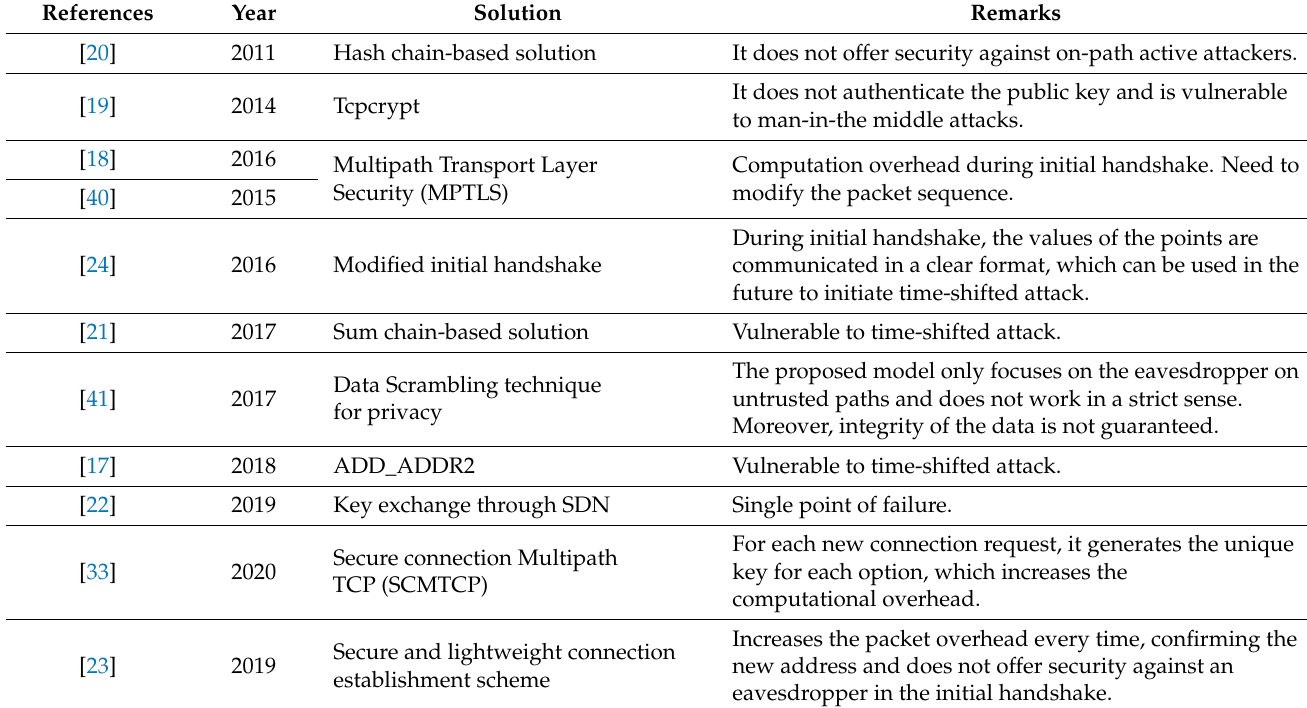
Table 3. Existing security solutions for